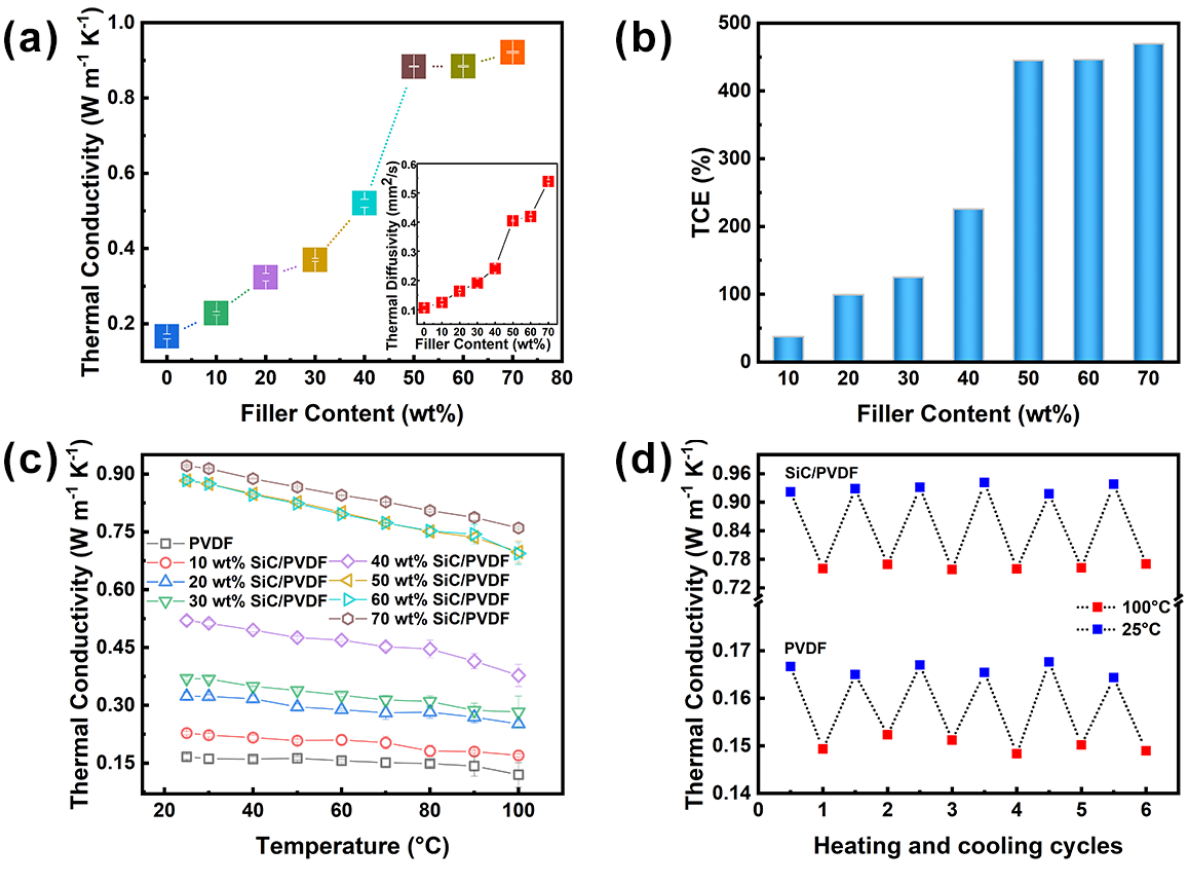
Figure 5. ( a ) Thermal conductivity, thermal diffusivity, and ( b ) thermal conductivity enhancement (TCE) of pure PVDF and SiC/PVDF composites with different filler content. Thermal conductivity of pure PVDF and SiC/PVDF composites with different filler content ( c ) as the temperature changes and ( d ) under multiple heating–cooling cycles.